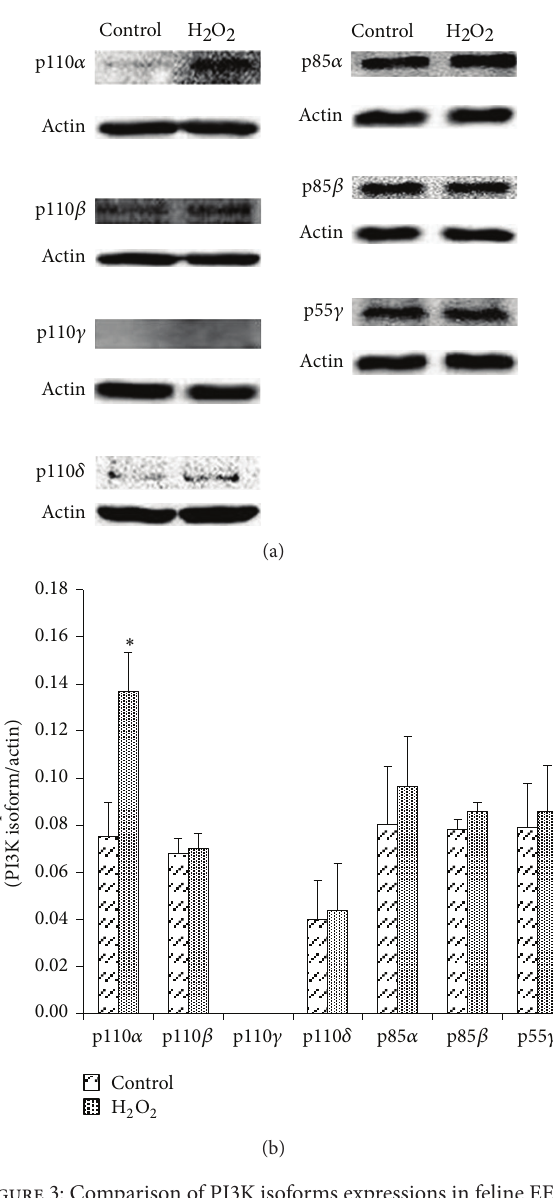
Figure 3: Comparison of PI3K isoforms expressions in feline EECs after treatment with H 2 O 2 . (a) Representative ( 𝑛 ≥ 3 ) Western blot analyses of the expression of the known class PI3K C (p110 𝛼 , p110 𝛽 , p110 𝛾 , and p110 𝛿 ) and R (p85 𝛼 , p85 𝛽 , and p55 𝛾 ) isoforms, using isoform-specific antibodies. Feline EECs were exposed to 300 𝜇 M H 2 O 2 for 6 hours. Actin expression was used as a loading control for normalization. (b) The Western blot bands were quantified in order to establish the relative expression levels for each analyzed isoform. Data are expressed as means ± S.E of three experiments (Student’s t -test; ∗ 𝑃 < 0.05 versus